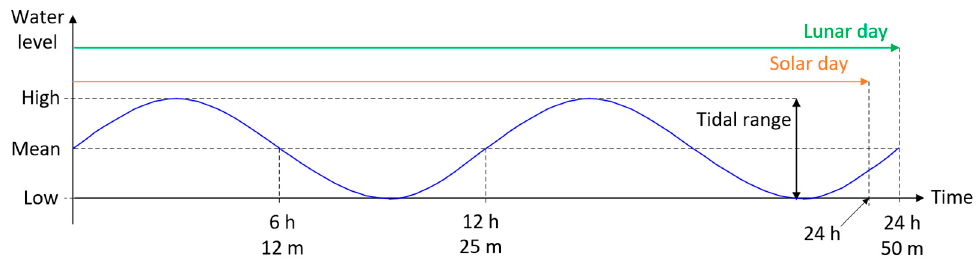
Figure 5. Comparison of the length of solar day and of lunar day, and typical variation of water levels at one location on Earth.